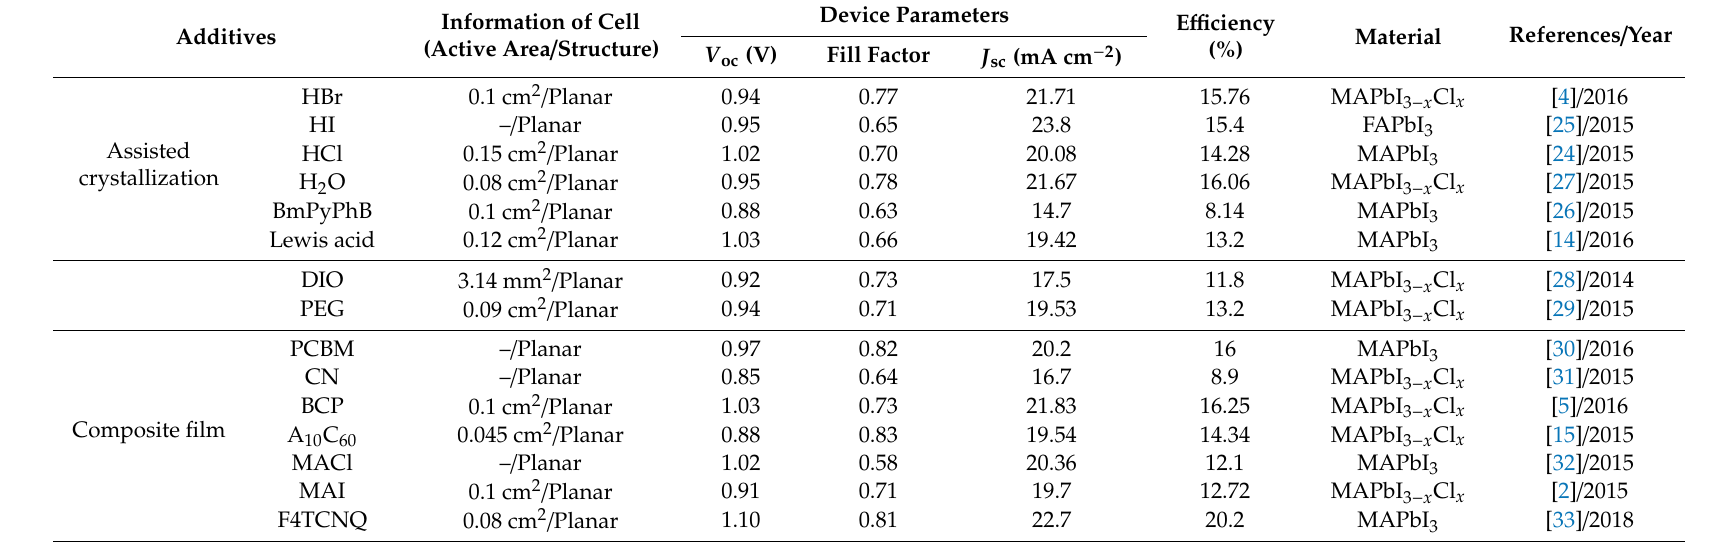
Table 1. Photovoltaic parameters of the representative utilizing additive in perovskiteprecursor solution to fabricate perovskite solar